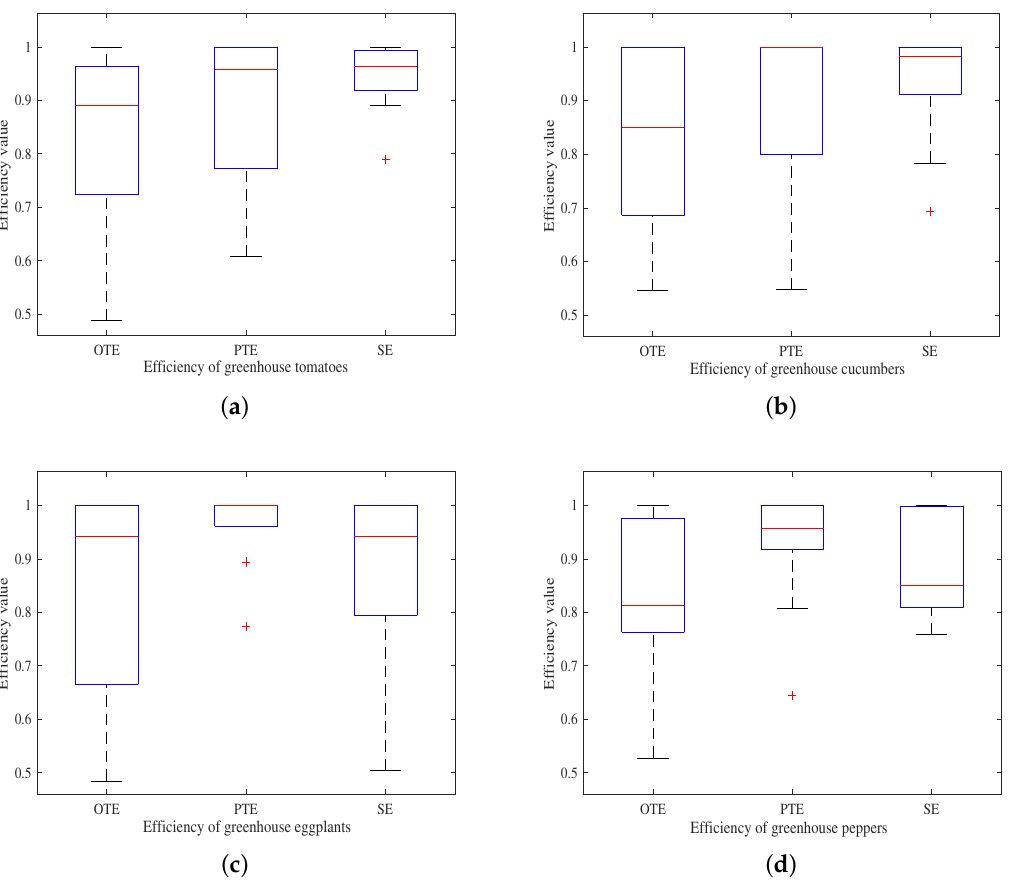
Figure 1. Boxplot of OTE, PTE, and SE of greenhouse tomatoes ( a ), greenhouse cucumbers ( b ), greenhouse eggplants ( c ) and greenhouse peppers ( d